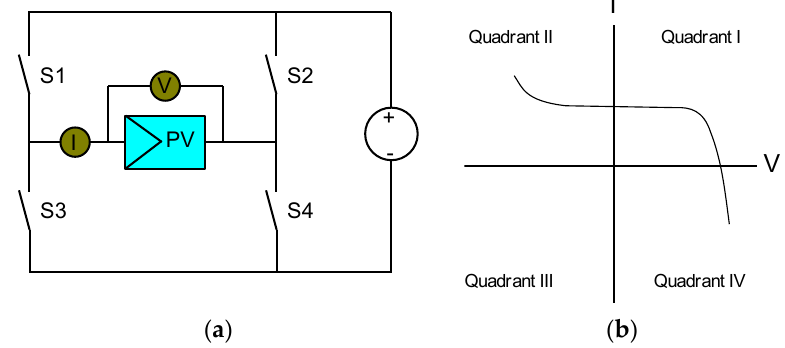
Figure 14. Four Quadrant Power Supply tracer. Source [16] , own elaboration.